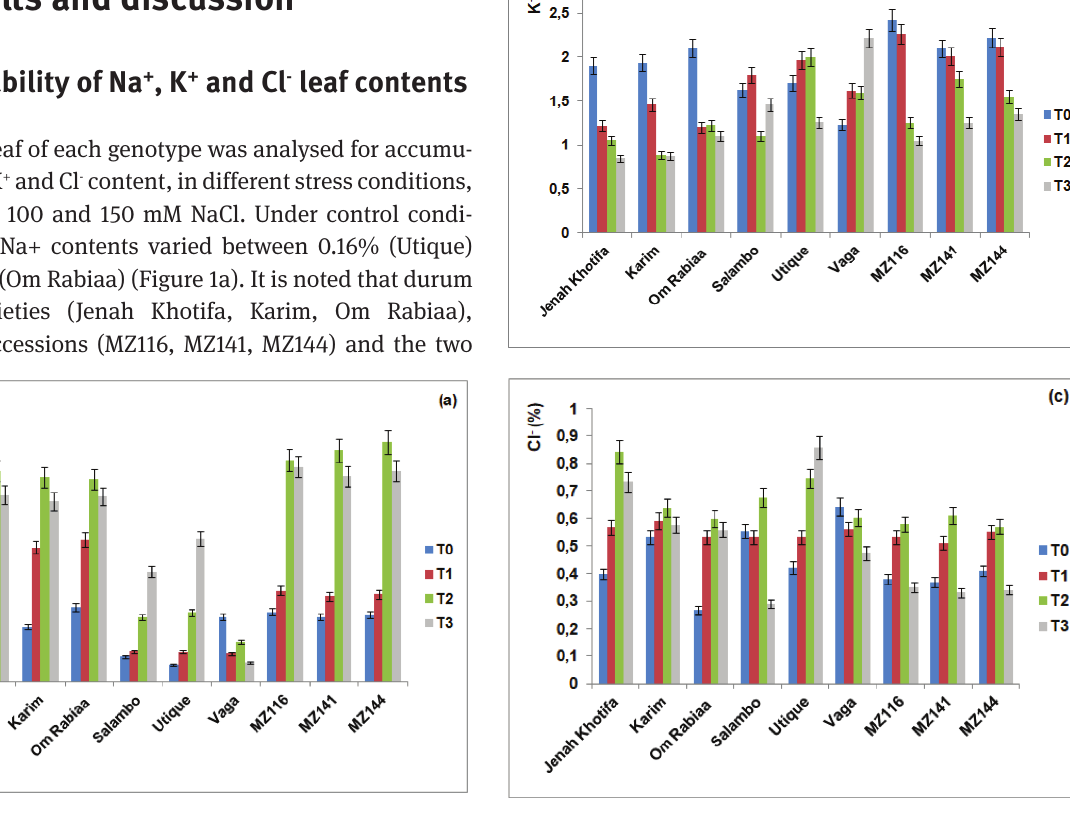
Figure 1: Variability of ions Na + (a), K + (b) and Cl - (c) leaf contents (%) among the investigated durum wheat (Jenah Khotifa, Karim, Om Rabiaa) and common wheat varieties (Salambo, Utique, Vaga) and wild wheat accessions (MZ116, MZ141, MZ144) according to the four salt treat- ments (T0=0, T1= 50, T2=100 and T3=150 mM